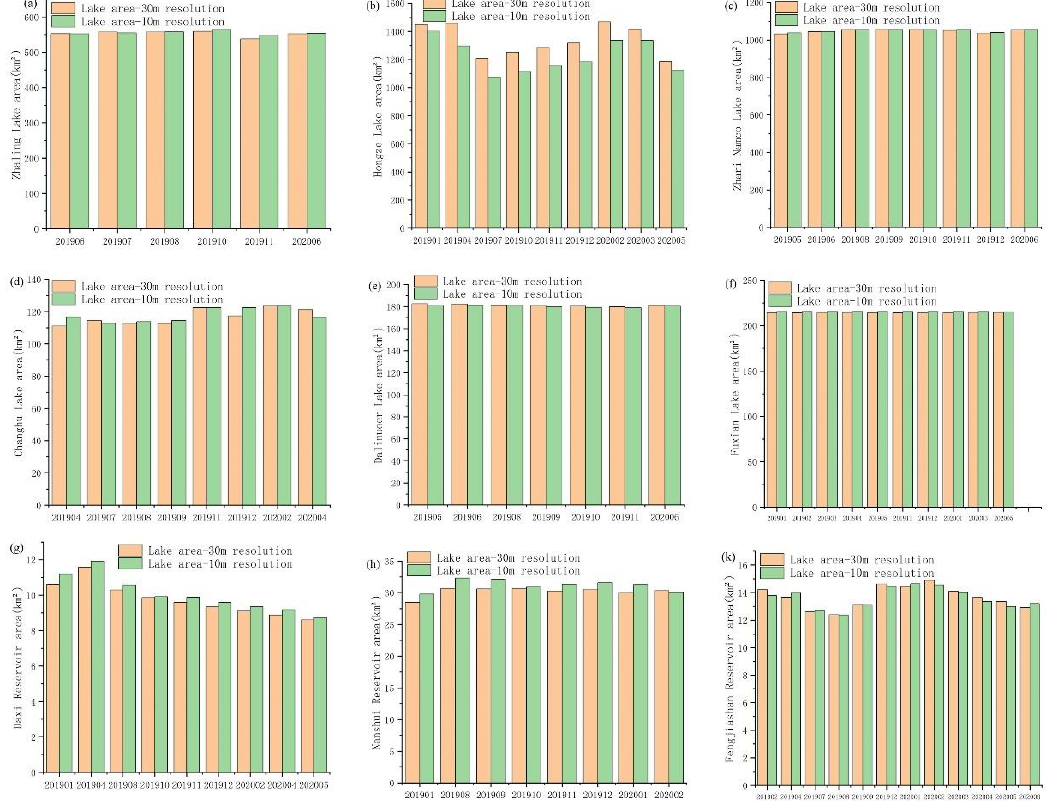
Figure 5. Comparison of two spatial resolution lake areas of large lakes ( a – c ), medium lakes ( d – f ), small lakes (g – k) .